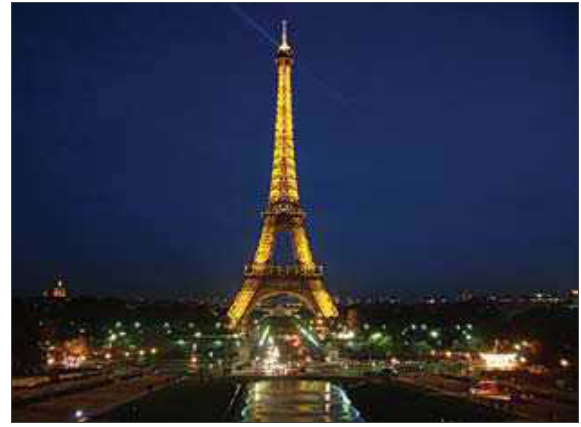
5 pav. eifelio bokštas Paryžiuje, 2006 m. autoriaus nuotraukos Fig. 5. eiffel tower in Paris,